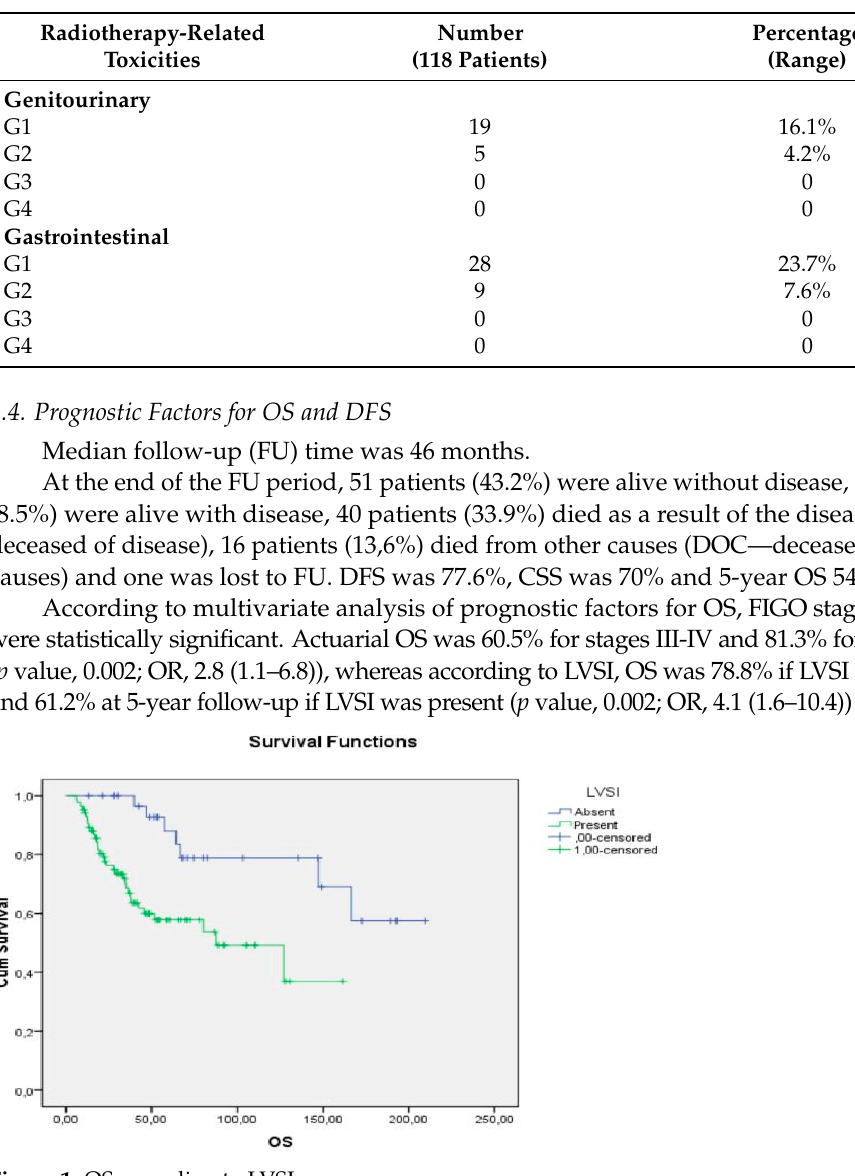
Table 3. Radiotherapy-related toxicities.